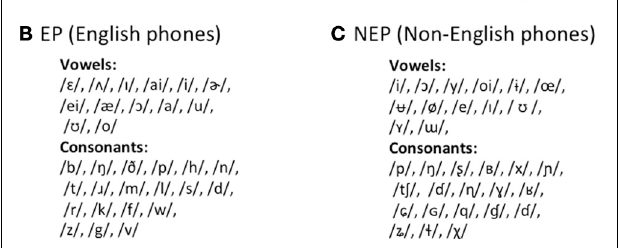
FIGURE 1 | EP and NEP languages. EP and NEP languages share the same grammar (A) , but have different phonological inventories (B,C) .